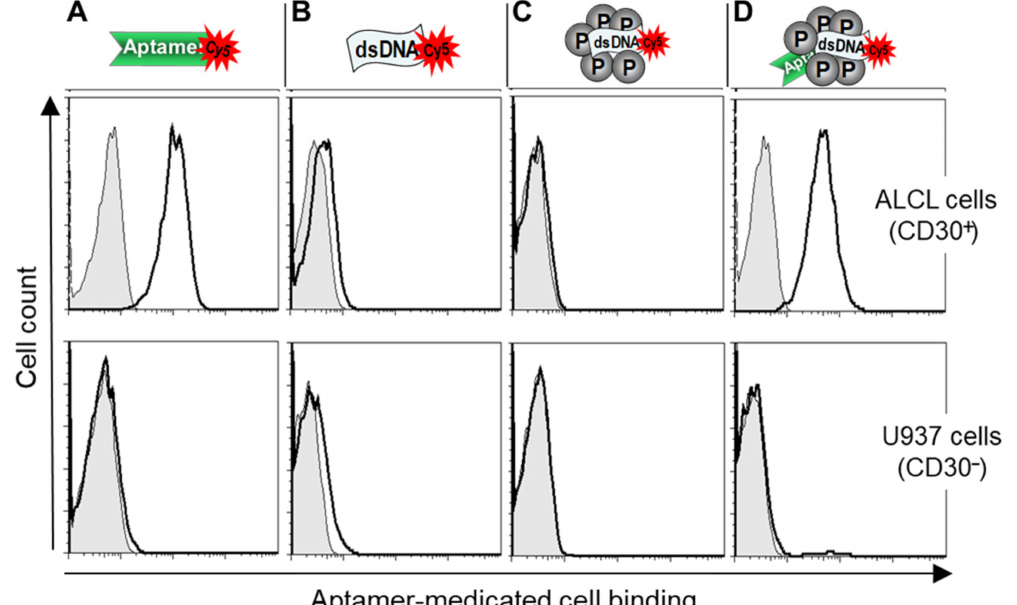
Figure 3. Aptamer-guided specific cell binding of the protamine nanoparticles. Cultured lymphoma cells, CD30-expressing Karpas 299 cells (upper panel), and CD30-negative U937 cells (lower panel), were treated with ( A ) an RNA-based CD30 aptamer probe alone, ( B ) synthetic dsDNA alone, ( C ) protamine nanoparticles composed of dsDNA, or ( D ) protamine nanoparticles composed of both CD30 aptamer and dsDNA. Resultant cell binding was evaluated by flow cytometry analysis. The data shown represent three independent experiments with similar